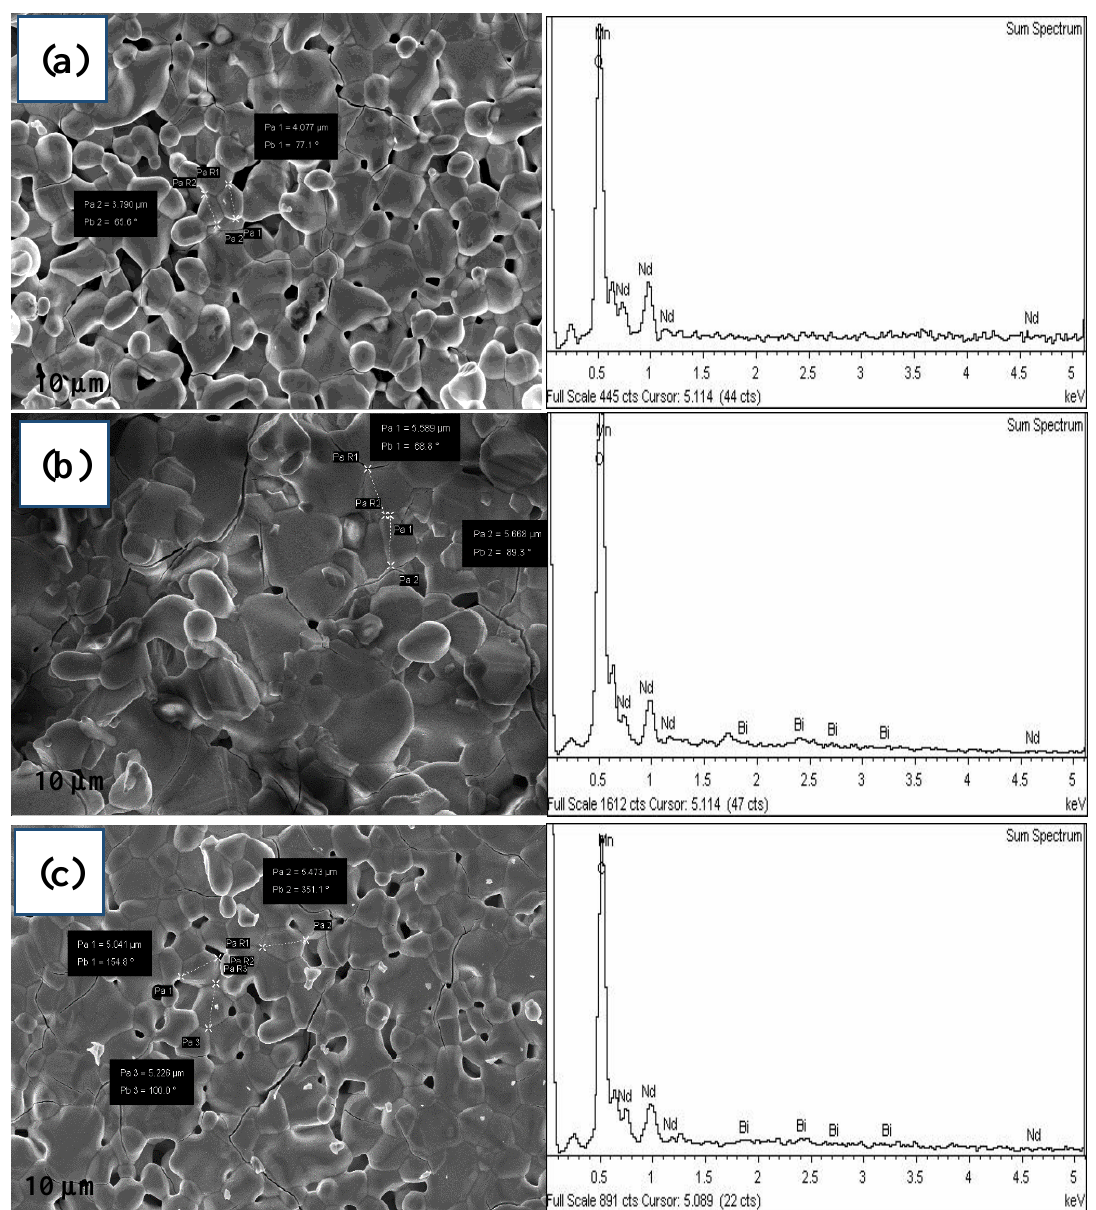
Figure 5. Field emission scanning electron microscopy (FESEM) micrograph and EDX spectra of Nd 1 − x Bi x MnO 3 ( a ) x = 0 ( b ) x = 0.25 and ( c ) x = 0.5.